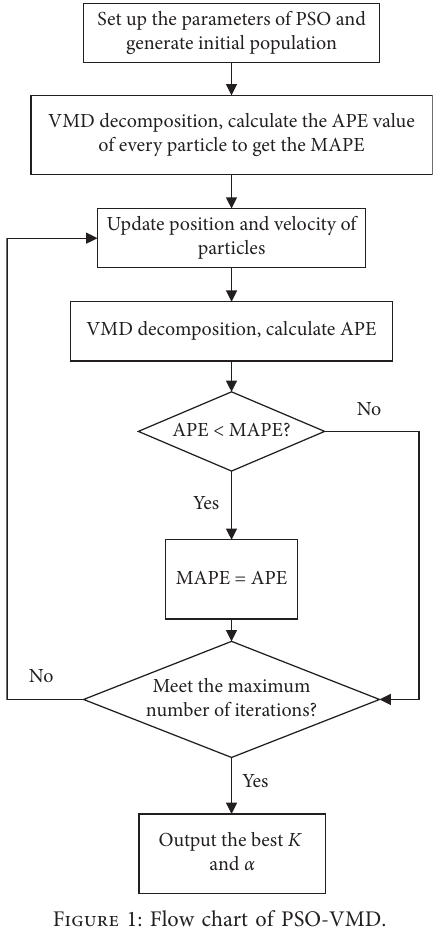
Figure 1: Flow chart of